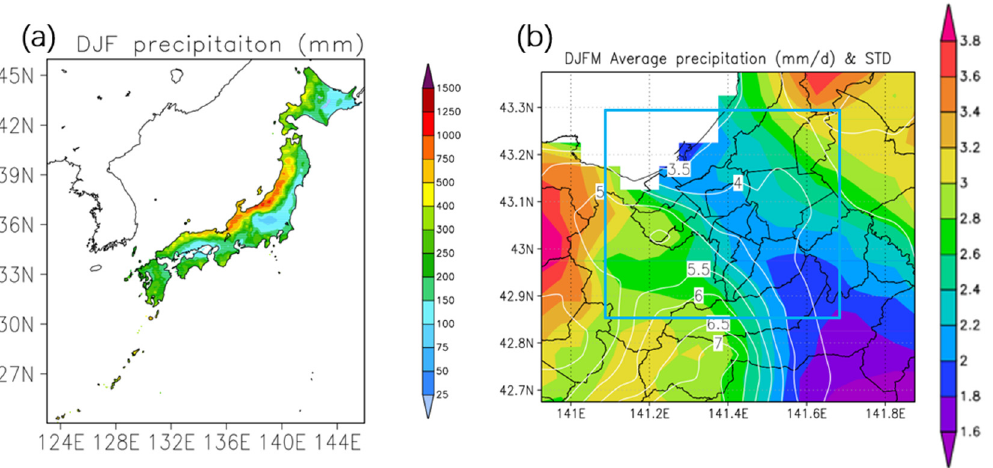
Figure 2. ( a ) Averaged winter (December, January and February) precipitation (unit: mm/3 months) for 1961–2008 by APHRO_JP [10]; ( b ) daily averaged precipitation (unit: mm/day, shown in color shade) and standard deviation (white contours) used in this study (December 1993–March 2015, December, January, February, and March were used). A light-blue rectangle indicates the target area.